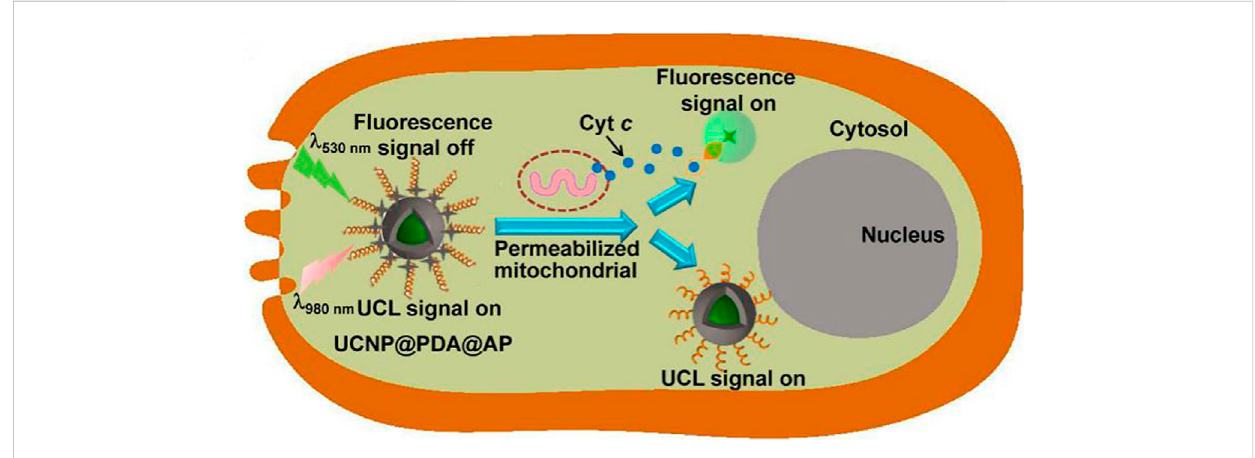
Illustration of the Ln-UCNPs@PDA@AP application for sensing intracellular Cyt c. The illustration is not drawn to scale. [Reprinted with permission from Ref. (Ma et al., 2017) Copyright 2017: